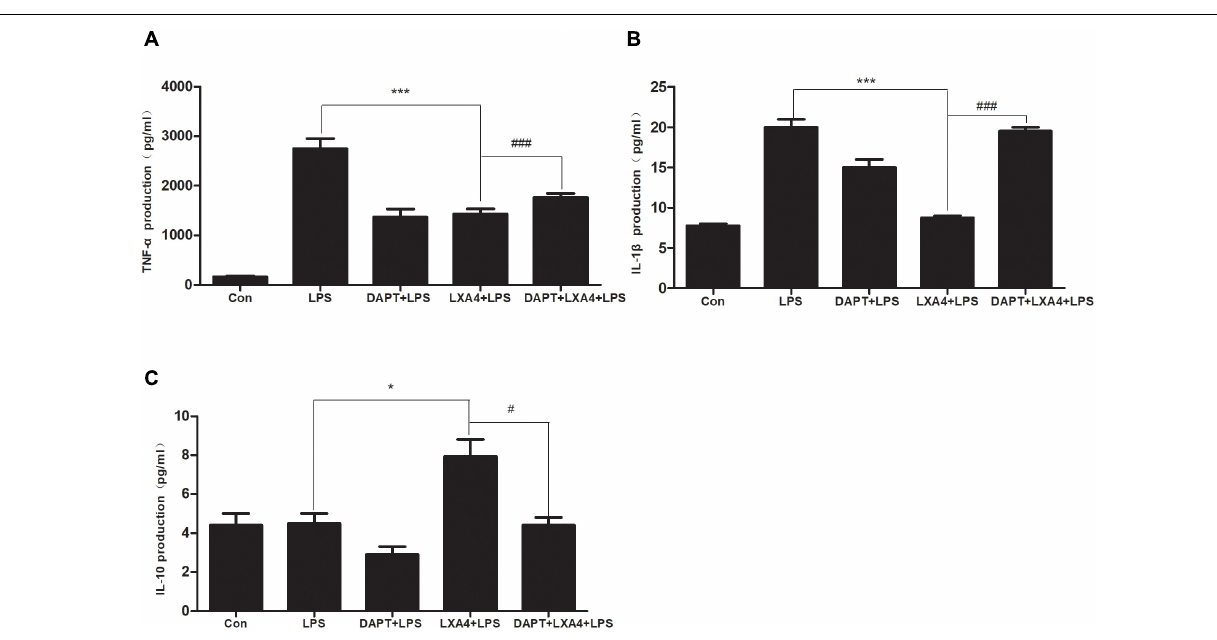
FIGURE 12 | LPS-induced microglia activation and release of inflammatory factors; After 6 h of LPS stimulating (A–C) : the protein expression levels of IL-1 β , TNF- α , IL-10 were measured by enzyme-linked immunosorbent assay (ELISA). # , ∗ p < 0.05; ## , ∗∗ p < 0.01; ### , ∗∗∗ p < 0.001; n.s., no